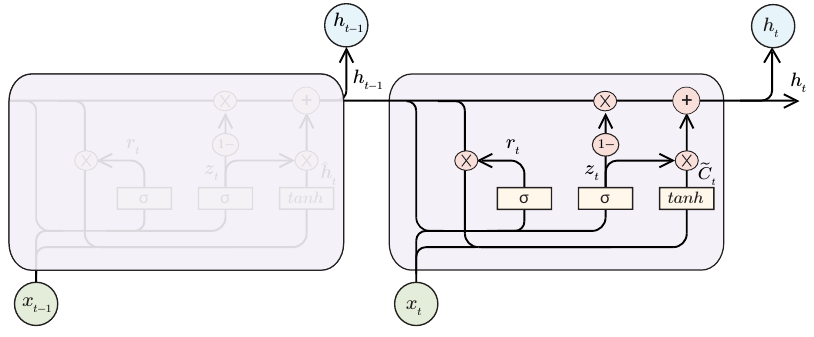
Figure 6. Gated Recurrent Unit